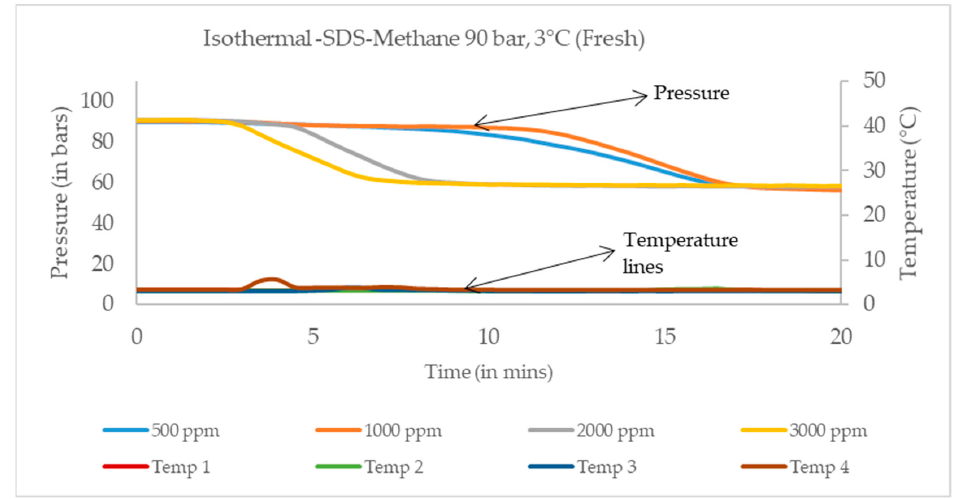
Figure 4. Graphical representation of isothermal experiments in shorter for different SDS concentrations with starting pressure 90 bar and T op = 3 ◦